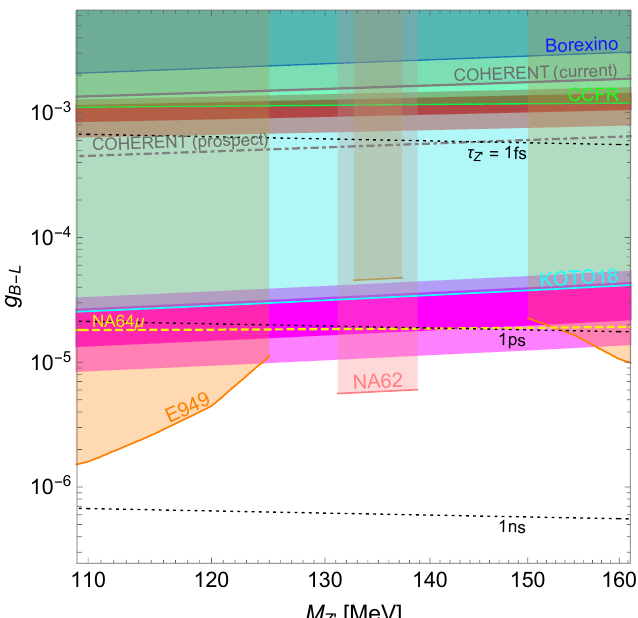
Figure 2 . Parameter space for ( g − 2) µ and KOTO result in the Scenario I. The red and magenta band show the favored region for ( g − 2) µ and KOTO result at 1 σ (darker) and at 2 σ (lighter), respectively. The other shaded regions are excluded by experiments: Borexino (blue) [43–45], COHERENT (gray) [46–49], CCFR (green) [60], E949 (orange) [30, 31], KOTO before the events (cyan) [25] and NA62 (pink) [32]. The dashed yellow and dashed-dotted gray lines are the future prospects of NA64 µ with 10 12 muons [61] and COHERENT, respectively. The dotted lines show the contours for the life time of Z 0 , calculated from eq.